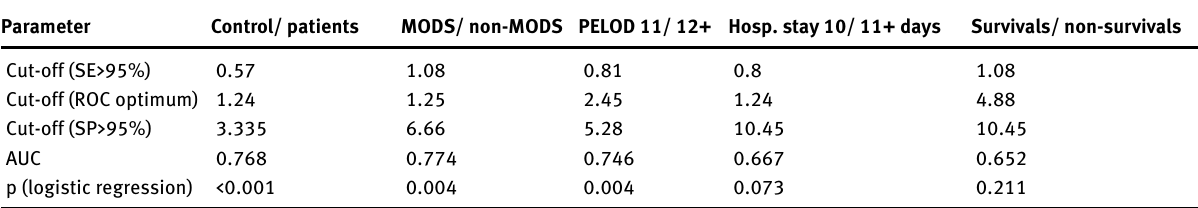
Table 4: Summary of ROC analysis and diagnostic characteristics of TFF3 on D1